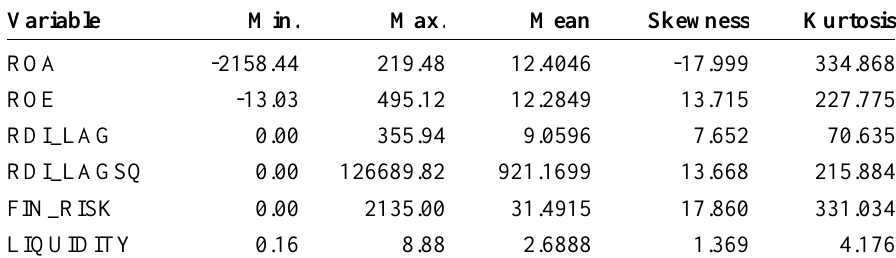
Table 1: Descriptive Statistics of Variables